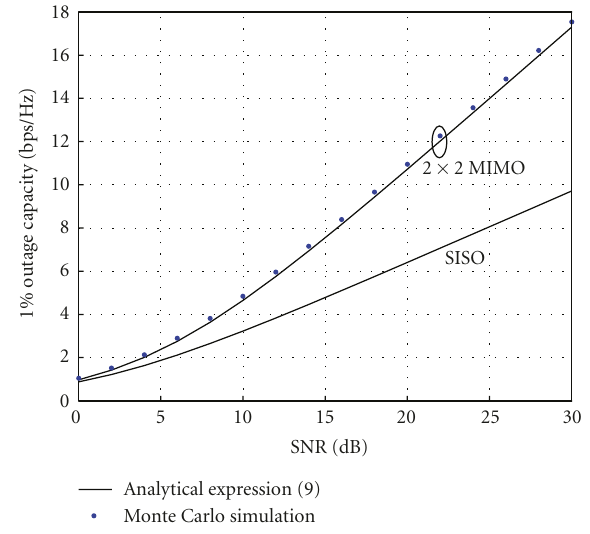
Figure 5: 1% outage capacity versus SNR for a satellite 2 × 2 MIMO spatial multiplexing system. Relevant SISO case is also plotted for comparison. Verification of analytical closed form expression in (9) through Monte Carlo simulation.